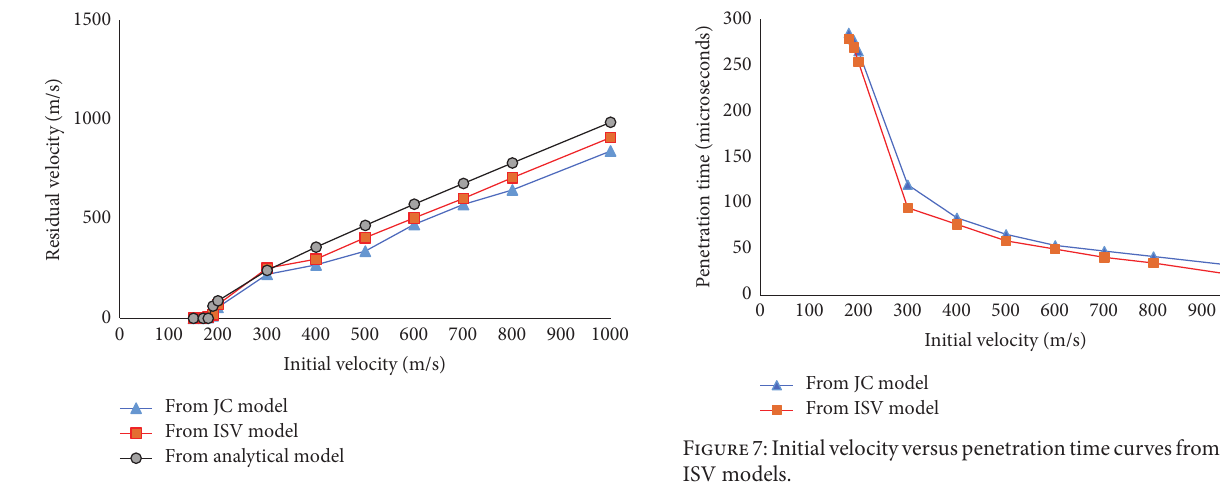
Figure 6: Initial velocity versus residual velocity curves from JC, ISV, and analytical models.